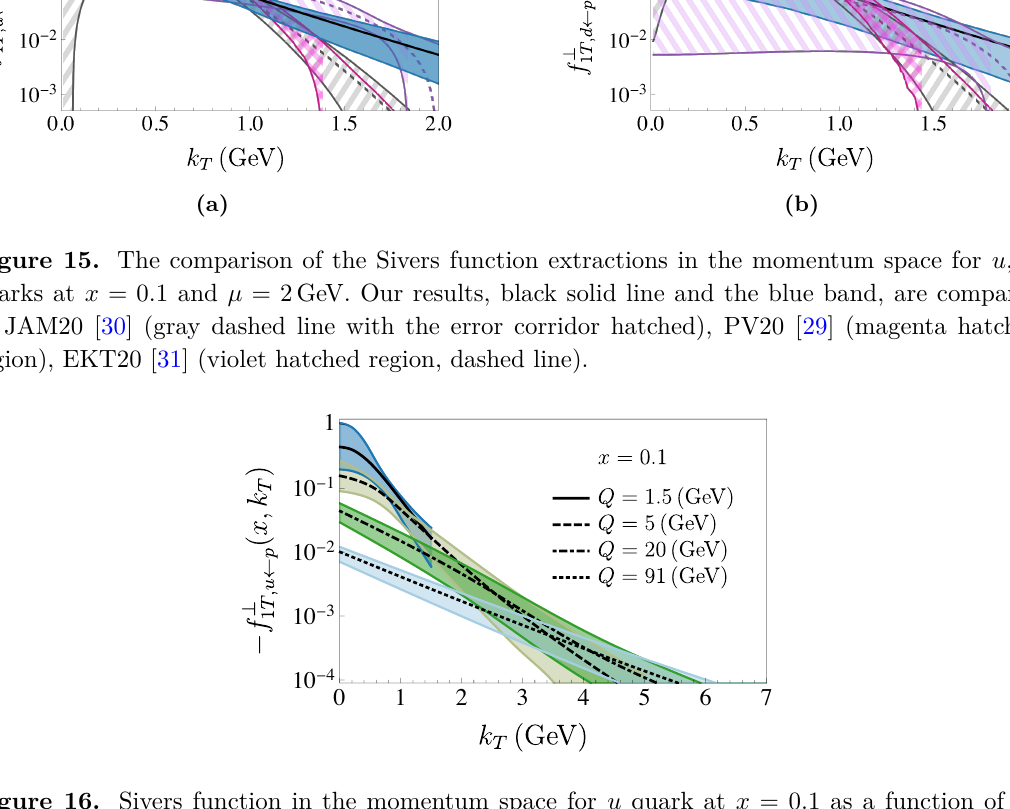
Figure 16. Sivers function in the momentum space for u quark at x = 0 . 1 as a function of k T (GeV). The bands are the 68%CI. The calculations are performed at four different values of Q